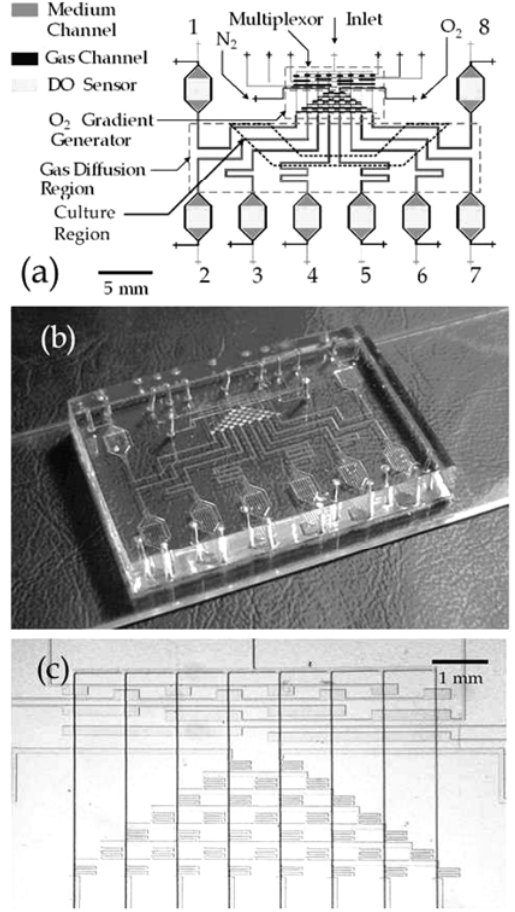
Figure 7. (a) Schematic diagram of the microfluidic oxygenator with integrated oxygen sensors. (b) Photograph of the fabricated oxygenator device. (c) Microscope image of the microfluidic multiplexor and oxygen concentration gradient generator. Reprinted from [55] with permission from the American Chemical